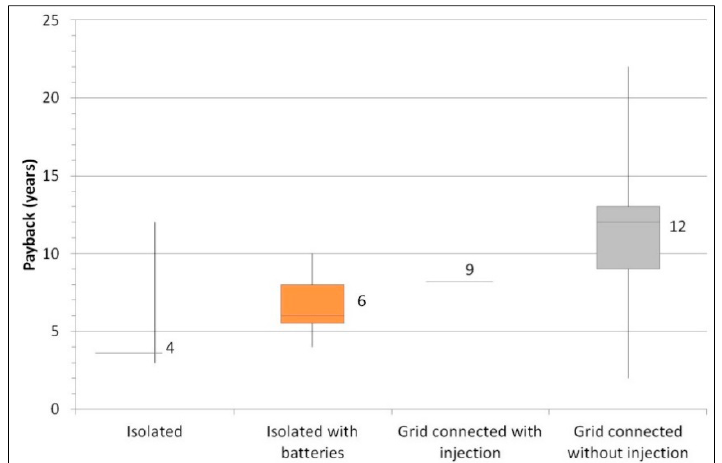
Figure 7. Payback of the facilities according to their connection to the grid.